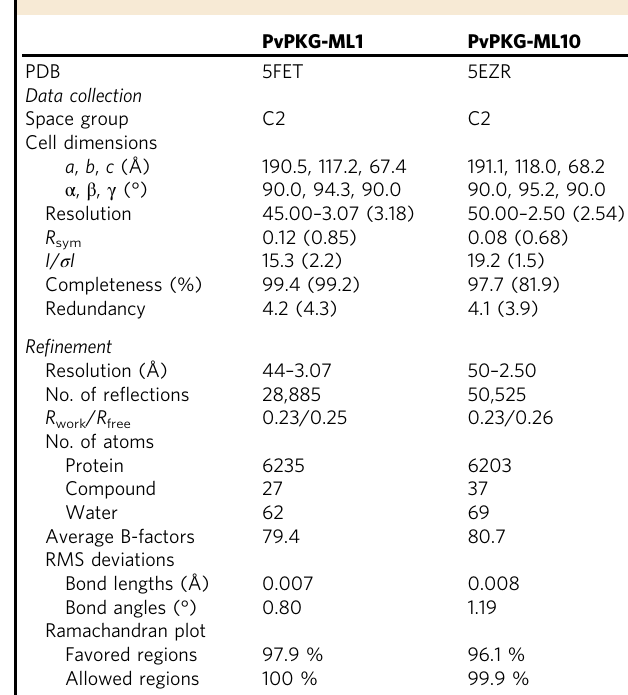
Table 2 Crystallography data collection and re fi